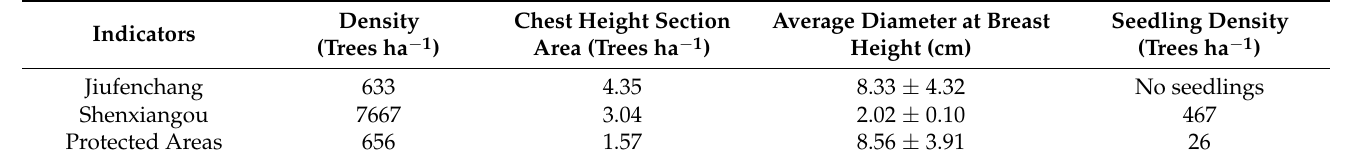
Table 2. Characteristics of stand structure of Morus alba in the different declining Robinia pseudoacacia